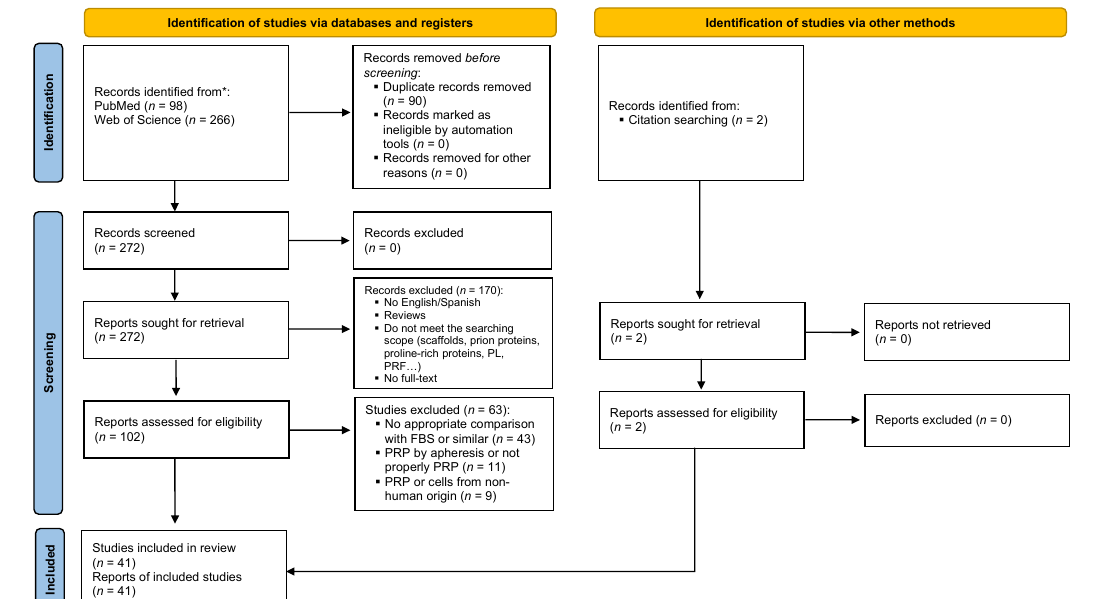
Figure 1. Flowchart summarizing the identification, screening, eligibility and inclusion of the studies in this review following the Preferred Reporting Items for Systematic Reviews and Meta-Analyses (PRISMA) guidelines.